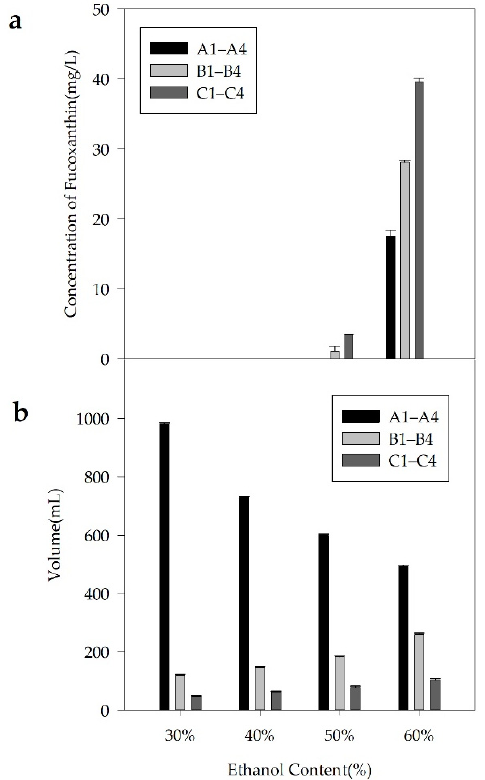
Figure 5. The FX concentration ( a ) and volume ( b ) of the solutions A1–A4, B1–B4, and C1–C4.